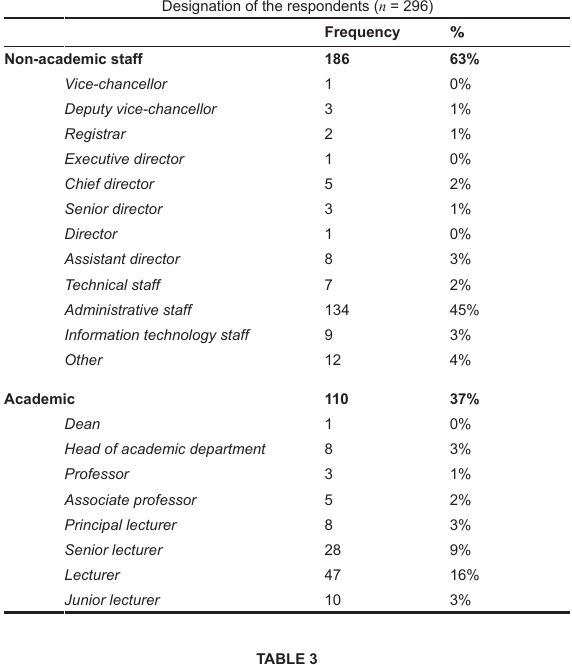
TABLE 2 Designation of the respondents ( n = 296)